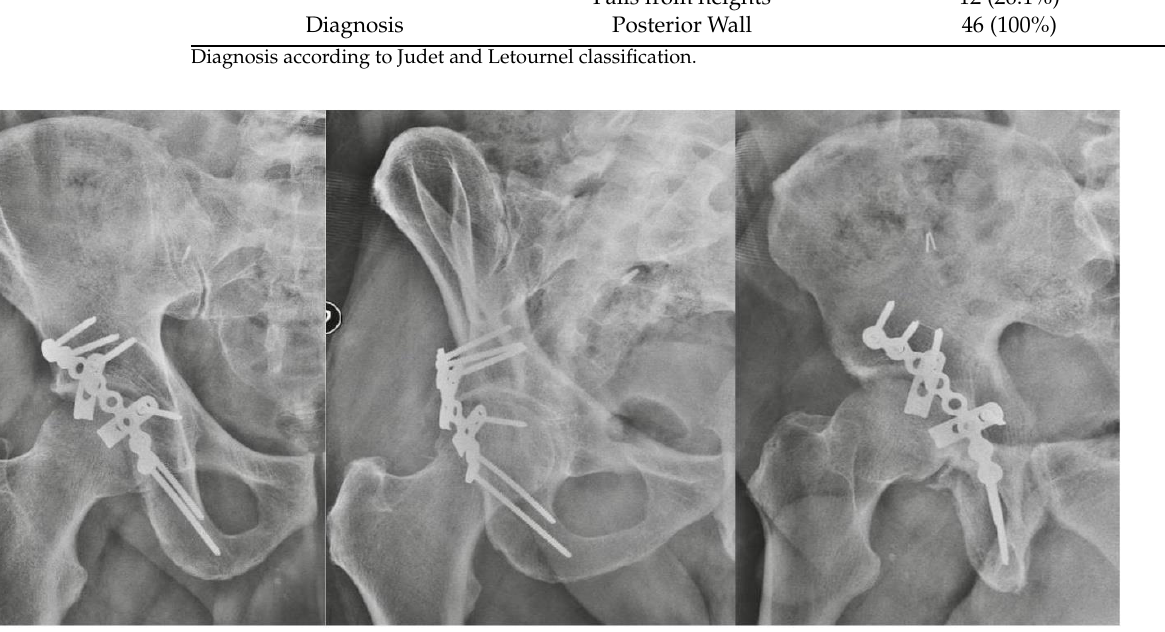
Figure 2. X-rays on AP view and Judet views showing spring plates used in addition to a reconstruction plate and interfragmentary screws.